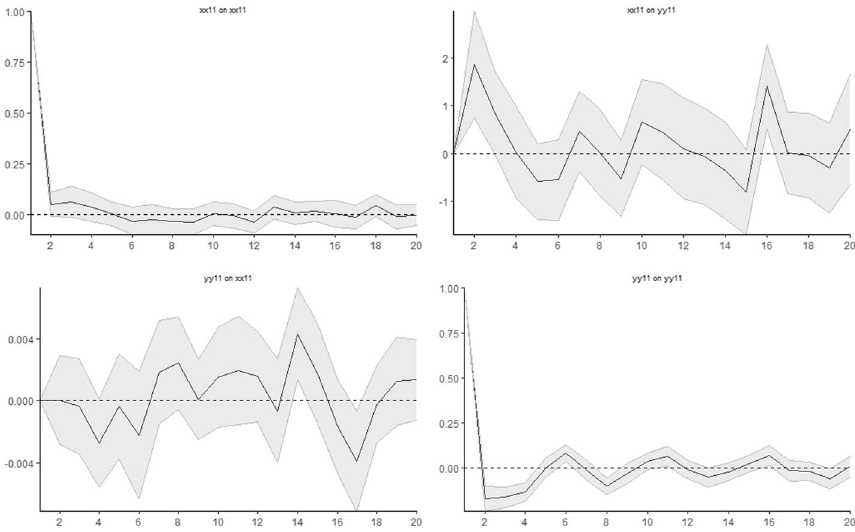
Fig. 3 Linear impulse response analysis. Note : Grey shaded area illustrates 95% confidence